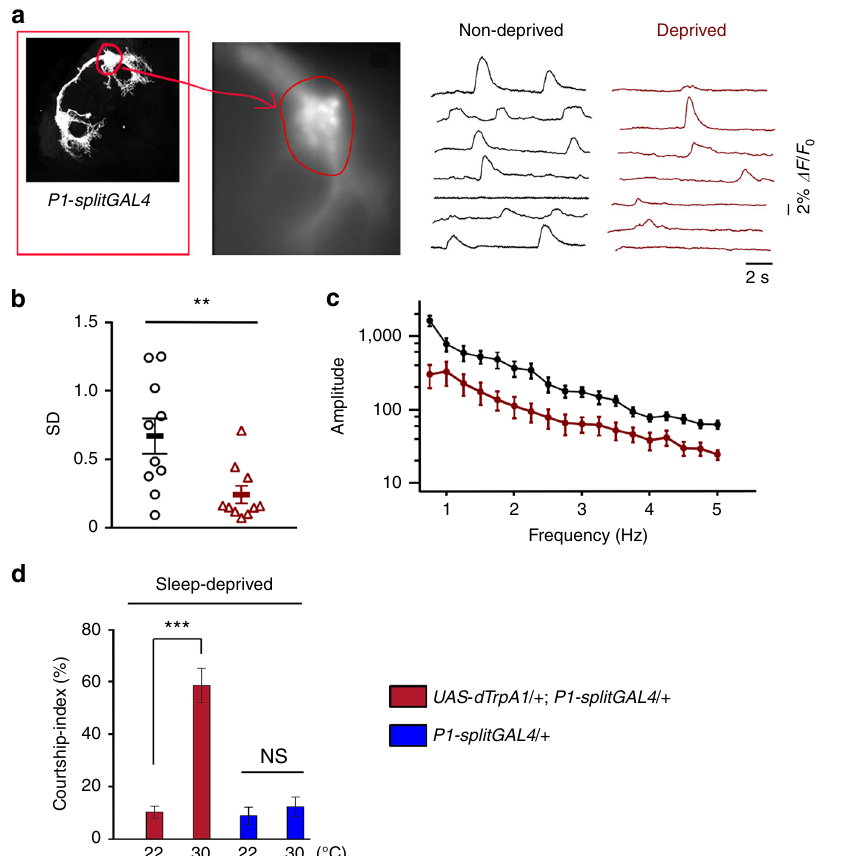
Fig. 7 SD decreases P1 activity. a Optical recording of membrane activity in the lateral junction ( circled ) of P1 neurons in control (non-deprived) males and sleep-deprived males. b SD of the optical signal was plotted, with mean ± SEM. n = 10 for each. ** p < 0.01, unpaired t- test. c Power spectrum was computed using fast Fourier transform with 0.2 Hz bin width. Power of the non-deprived group is signi fi cantly greater than the sleep-deprived group (two- way ANOVA with repeated measures). d Activating P1 neurons with dTRPA1 overcomes courtship suppression by SD. n = 24 for each. *** p < 0.001, unpaired t- test. NS , not signi fi cant. Error bars indicate